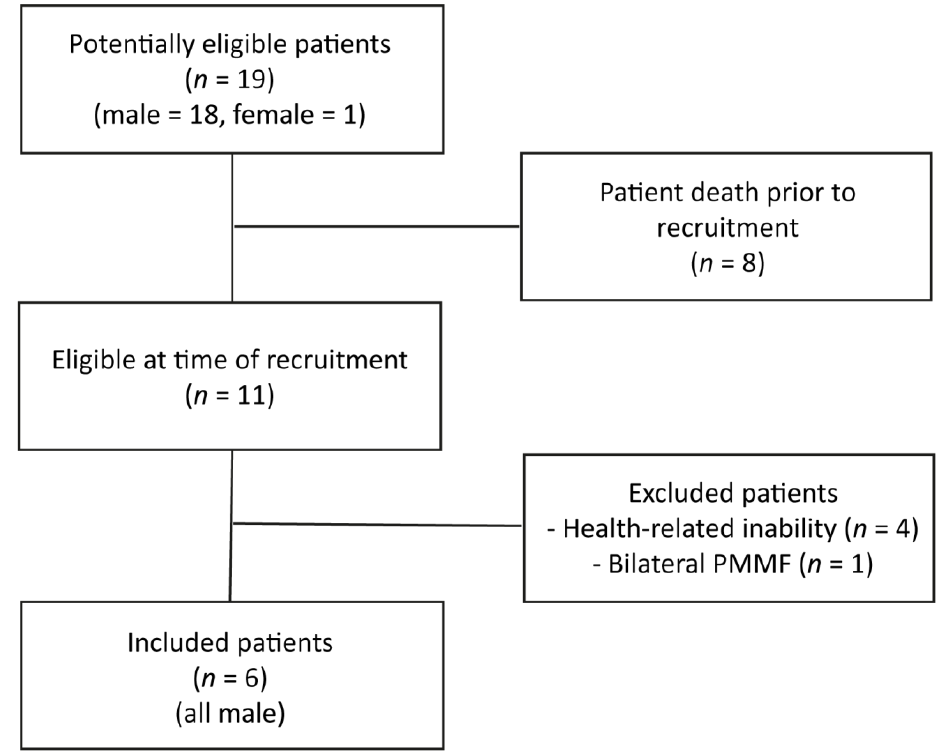
Figure 1. Patient inclusion process.